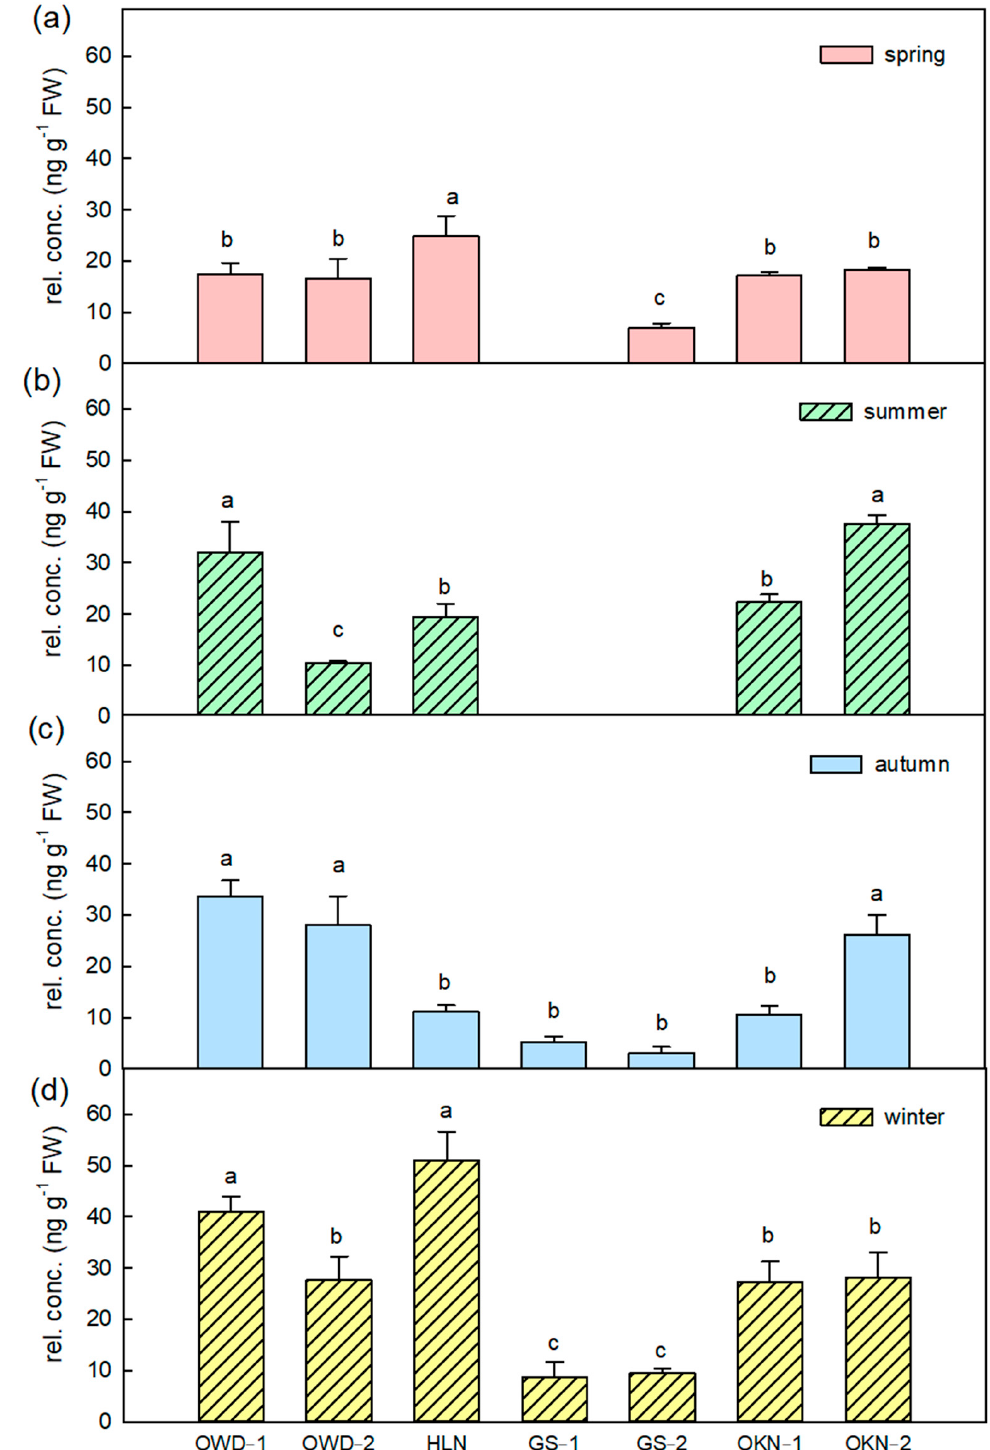
Figure 5. The caryophyllene variations in Citrus depressa fresh leaf among all accessions in each season, which is ( a ) spring; ( b ) summer; ( c ) autumn; and ( d ) winter. Each bar shows the average ( n = 3) of the relative concentration (rel. conc.) The error bar was calculated by standard errors, and the different letters show a significant difference (LSD p < 0.05).